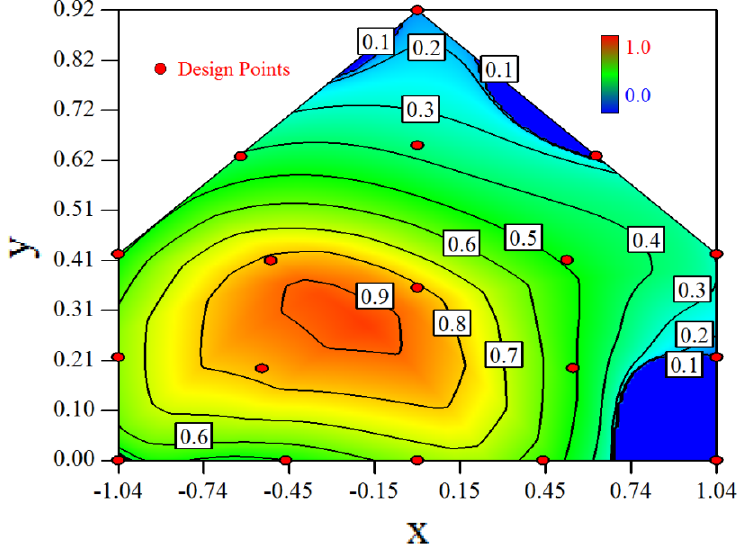
Figure 3. Desirability graph for the optimization of the concentration ratio within the design space, in which the optimal position = 0.93 shows the optimal position for the concentration measurement of all cases (Cases 1–8). The coordinates of this position are x = − 0.2 , y = 0.27